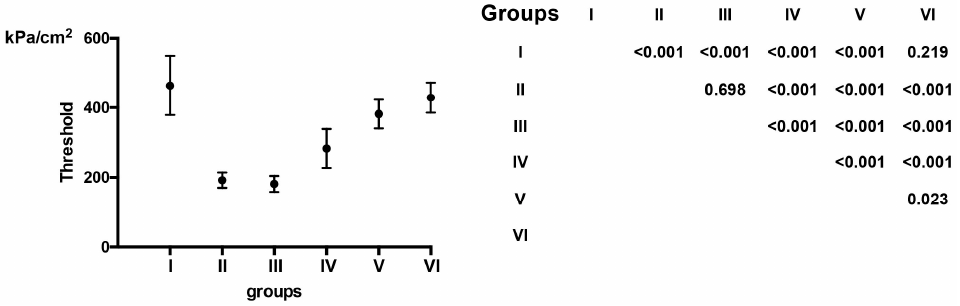
Figure 1. Pain threshold values in the RAR of healthy controls and patients with Bell’s palsy on the affected side. Pain threshold levels of each group are presented as average (lack dots) ± standard deviation (whiskers). One-way ANOVA revealed a statistically significant difference among the groups and Tukey’s HSD post hoc p values are presented.